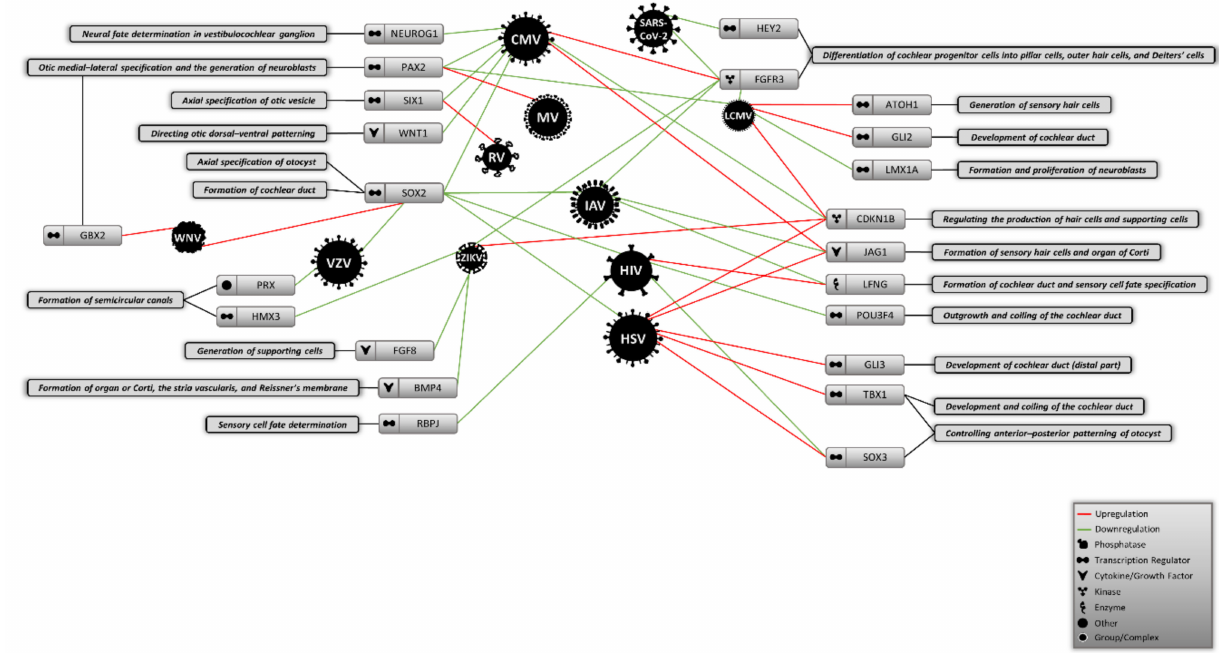
Figure 1. Proposed model of potential virus-induced molecular alterations during the initial stages of auditory system development. CMV: Cytomegalovirus, MV: Measles virus, LCMV: Lymphocytic choriomeningitis virus, RV: Rubella virus, IAV: Influenza A virus, HIV: Human immunodeficiency virus, HSV: Herpes simplex virus, ZIKV: Zika virus, VZV: Varicella zoster virus, WNV: West Nile